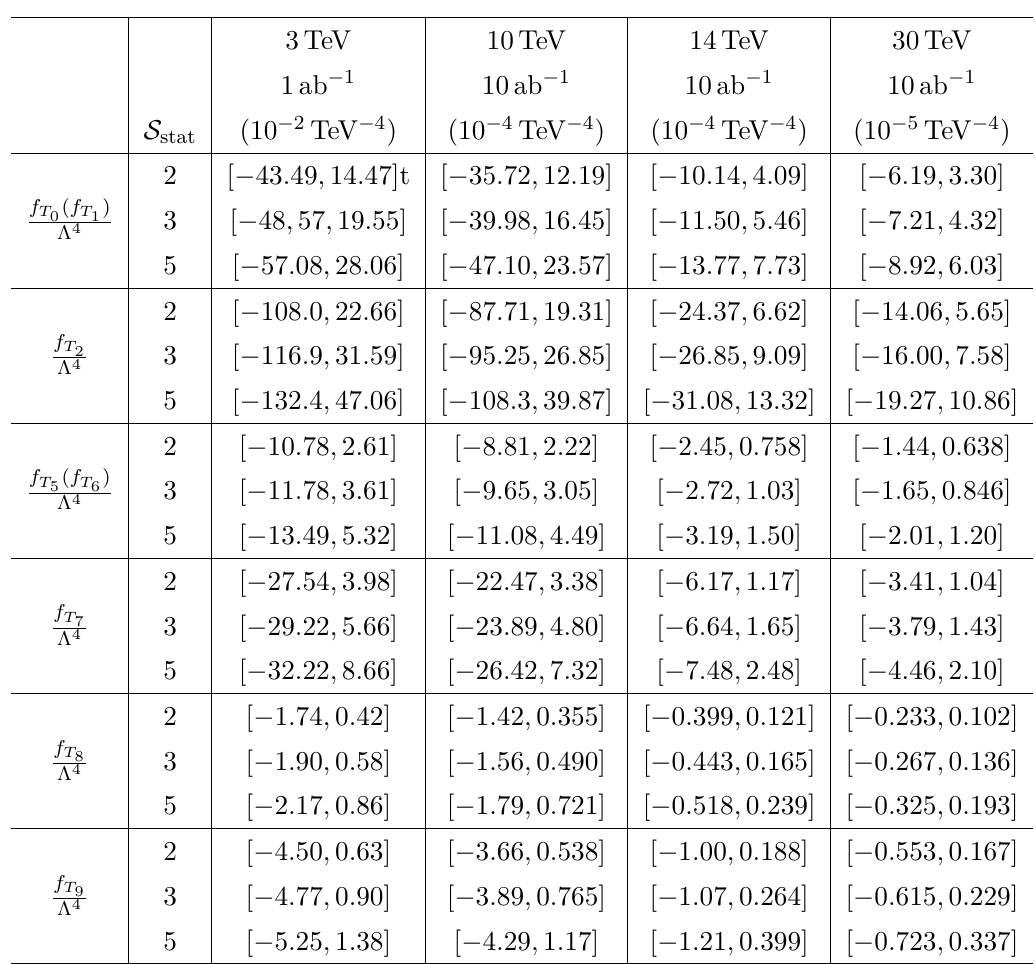
Table 5 . The projected sensitivities on the aQGC coefficients at the muon colliders with different c.m. energies and integrated luminosities for “conservative”